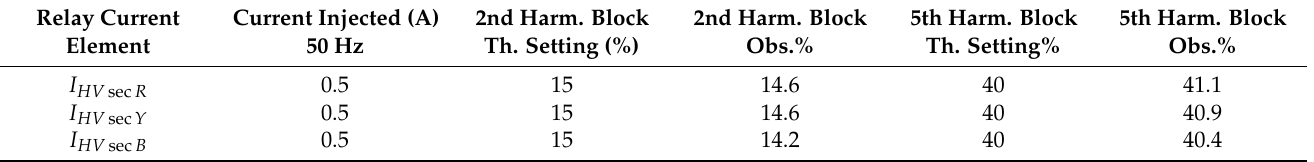
Table 11. Test results of effect of setting ‘ I S − H S 1 ’ and 2nd harmonic component on differential protection status. HV Side Relay Element